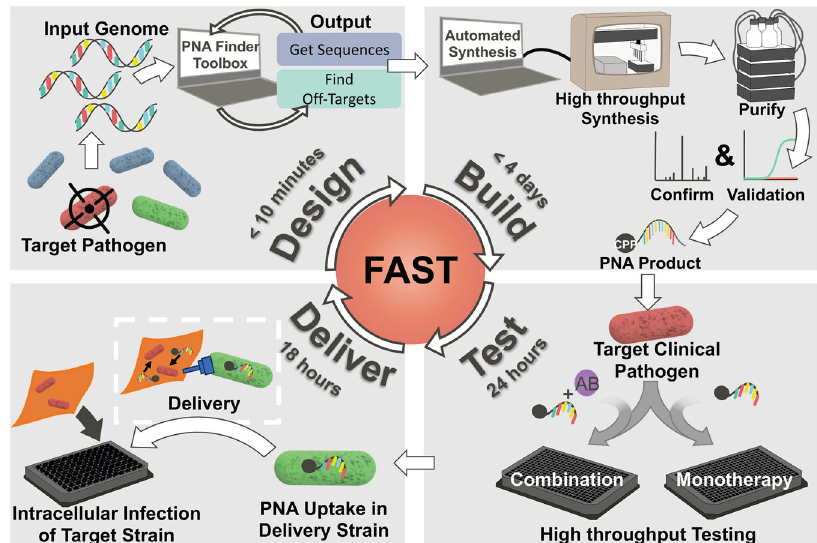
Fig. 1 Facile Accelerated Speci fi c Therapeutic (FAST) platform from design to delivery of PNA to treat MDR bacteria in less than 1 week. The FAST pipeline is capable of producing effective therapies against MDR bacteria by combining design, synthesis, testing, and delivery modules. Design (top left corner): The corresponding reference genome of target pathogen(s) is inputted into the PNA Finder bioinformatics toolbox which generates a list of PNA sequences in less than 10 min. Build (top right corner): Promising PNA candidates are synthesized using high throughput, automated solid-phase synthesis chemistry. Puri fi cation of the PNA product is done using HPLC and validation is performed through LC – MS. The entire process is completed in less than 4 days. Test (bottom right corner): The puri fi ed and veri fi ed PNA is tested on clinical isolates within 1 day to evaluate therapeutic potential for monotherapy or combination (with antibiotic (AB)) treatments. Delivery (bottom left corner) Top PNA candidates are delivered to infected mammalian cells by repurposing the bacterial type III secretion system (T3SS) mediated delivery system to clear a secondary (red bacteria) intracellular